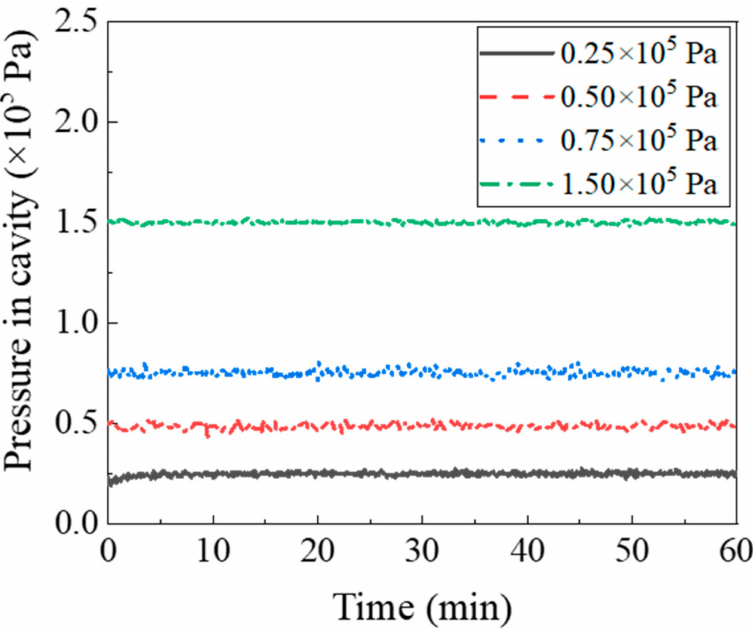
Figure 3. Transient working pressure in the cavity during the